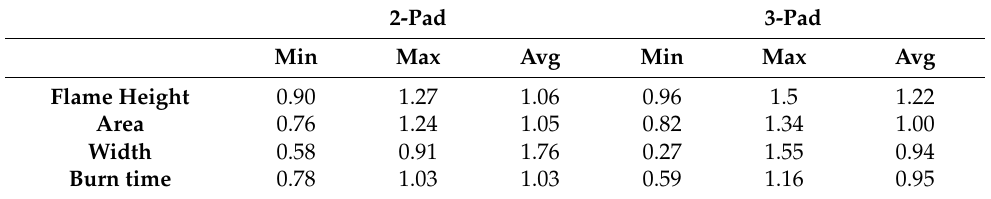
Table 8. Maximum and minimum flame dimensions (corrected) and burning